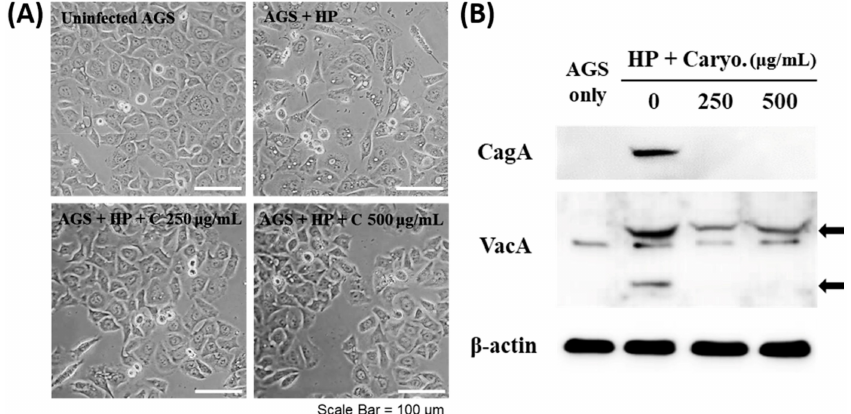
Figure 4. Inhibitory e ff ect of β -caryophyllene on CagA and VacA translocation into AGS cells by H. pylori . AGS cells were infected with H. pylori (200 MOI) and treated with indicated dose of β -caryophyllene (250 and 500 µ g / mL) for 24 h. After incubation, ( A ) morphological changes were observed with an inverted microscope ( × 200). ( B ) The cell lysates were assessed by Western blotting to detect translocated CagA and VacA proteins to AGS cells.